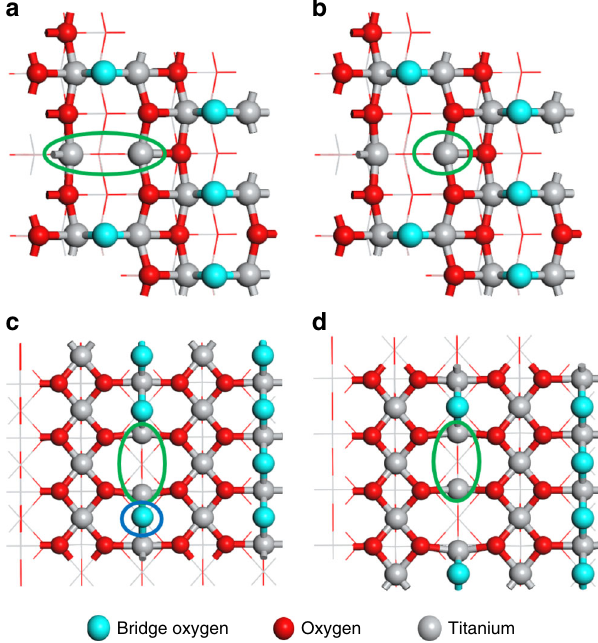
Fig. 2 DFT calculations of four types of Ti 3 + sites. a The adjacent bi-Ti 3 + on anatase (101) surfaces with one oxygen vacancy (i.e., A(101)-Vo); b the single Ti 3 + with four coordination on anatase (101) surfaces with one oxygen vacancy; c the adjacent bi-Ti 3 + on rutile (110) surfaces with one oxygen vacancy (i.e., R(110)-Vo); d the adjacent bi-Ti 3 + on rutile (110) surfaces with a pair of oxygen vacancies together, (i.e., R(110)-2Vo ’ s). The light-blue spheres stand for the lattice oxygens at the bridge sites where the surface oxygen vacancies are formed most easily. The red spheres stand for the other lattice oxygens on the surfaces and the gray spheres stand for the titanium cations. All four types of the active site models are highlighted by using the green circles. As compared c and d , the bridge lattice oxygen (circled in blue) can exert a large repulsion with the chemisorbed N 2 if it adopts a lying-down